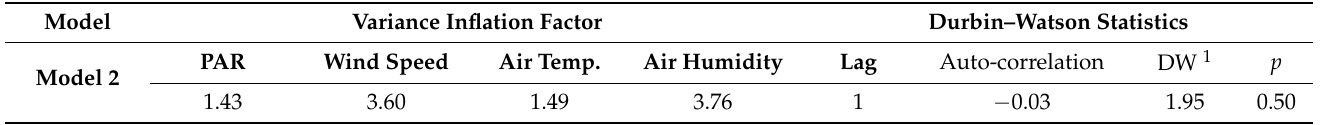
Table 4. Variance inflation factor (VIF) and Durbin–Watson statistics results of Model